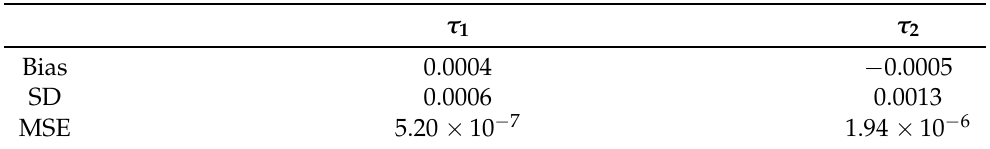
Table 1. Bias, SD and MSE according to the parameter τ for GNFPLSIM with the identity link function and n = 500.